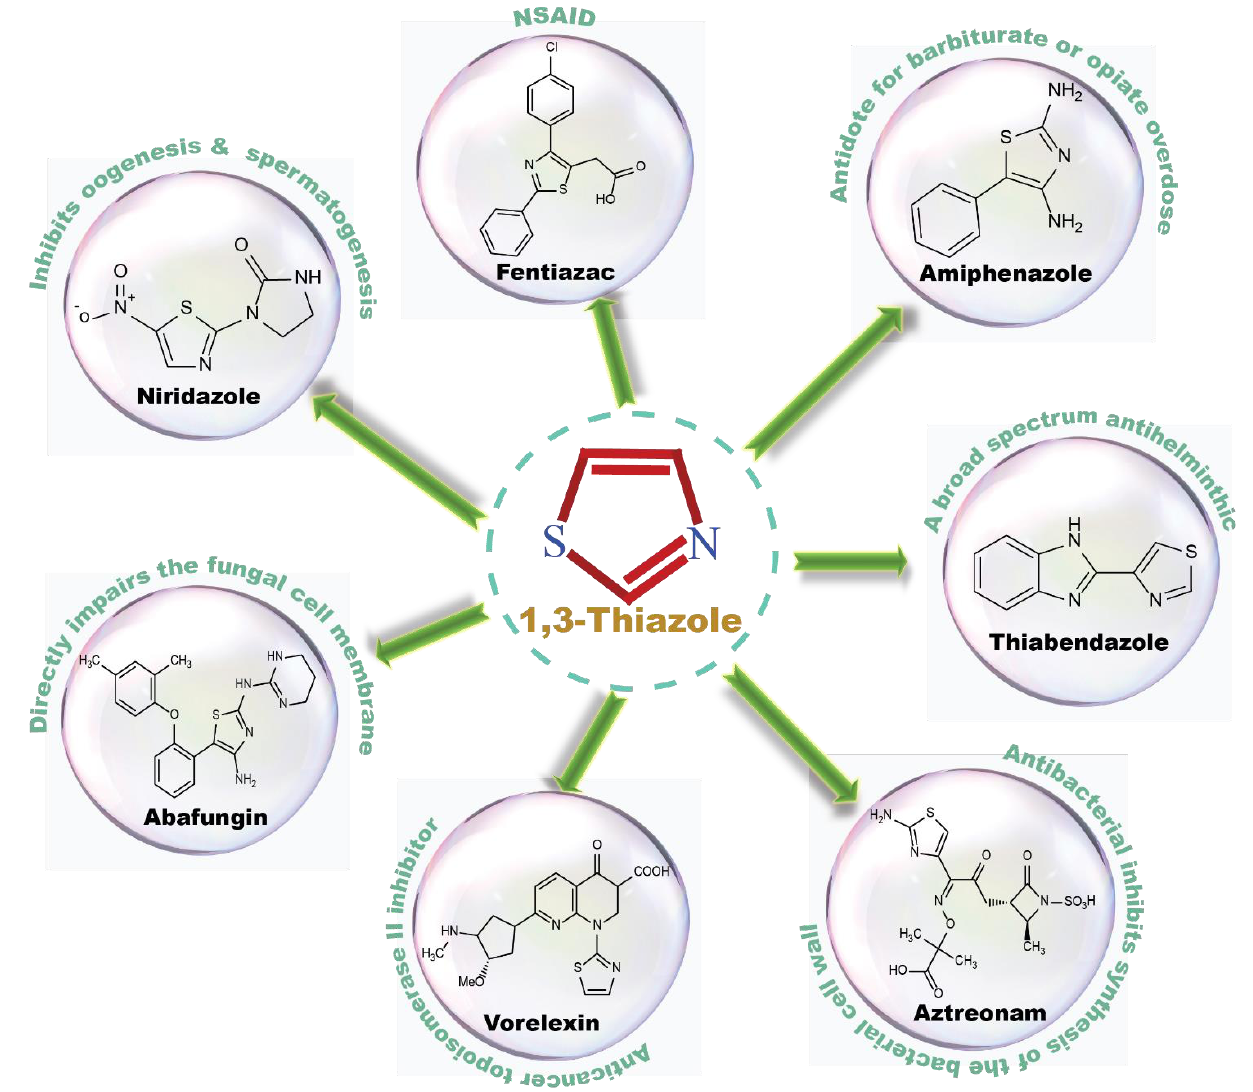
Figure 2. Some of the active pharmaceutical ingredients bearing thiazole ring.